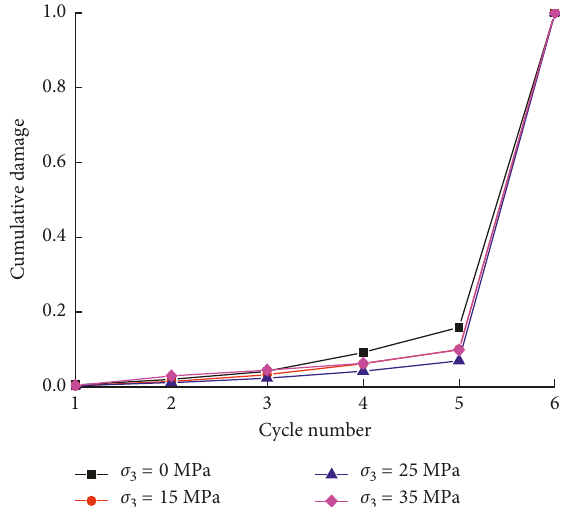
Figure 11: Plots of cumulative damage based on energy